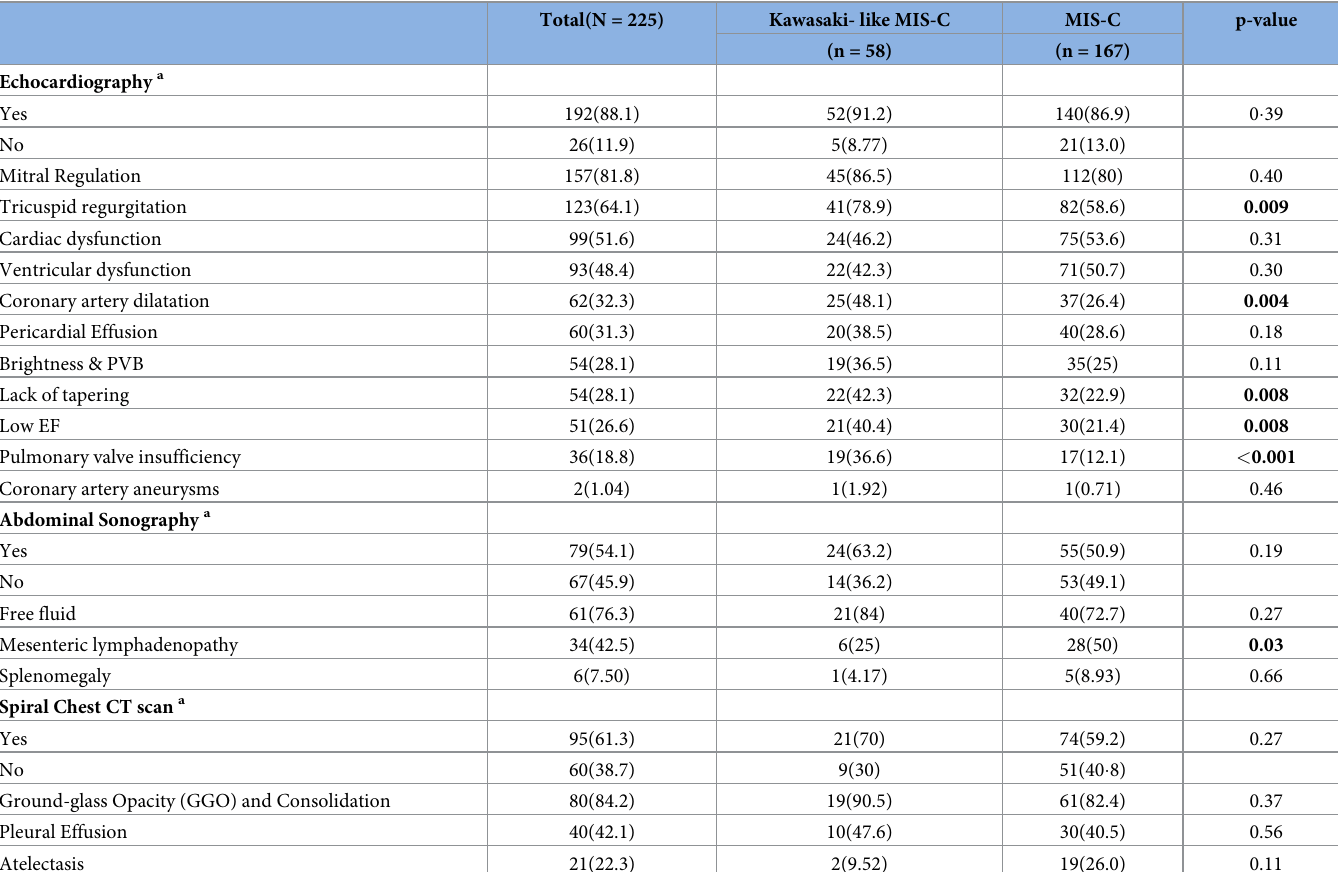
Table 5. Characteristic of imaging in Kawasaki- like MIS-C and MIS-C